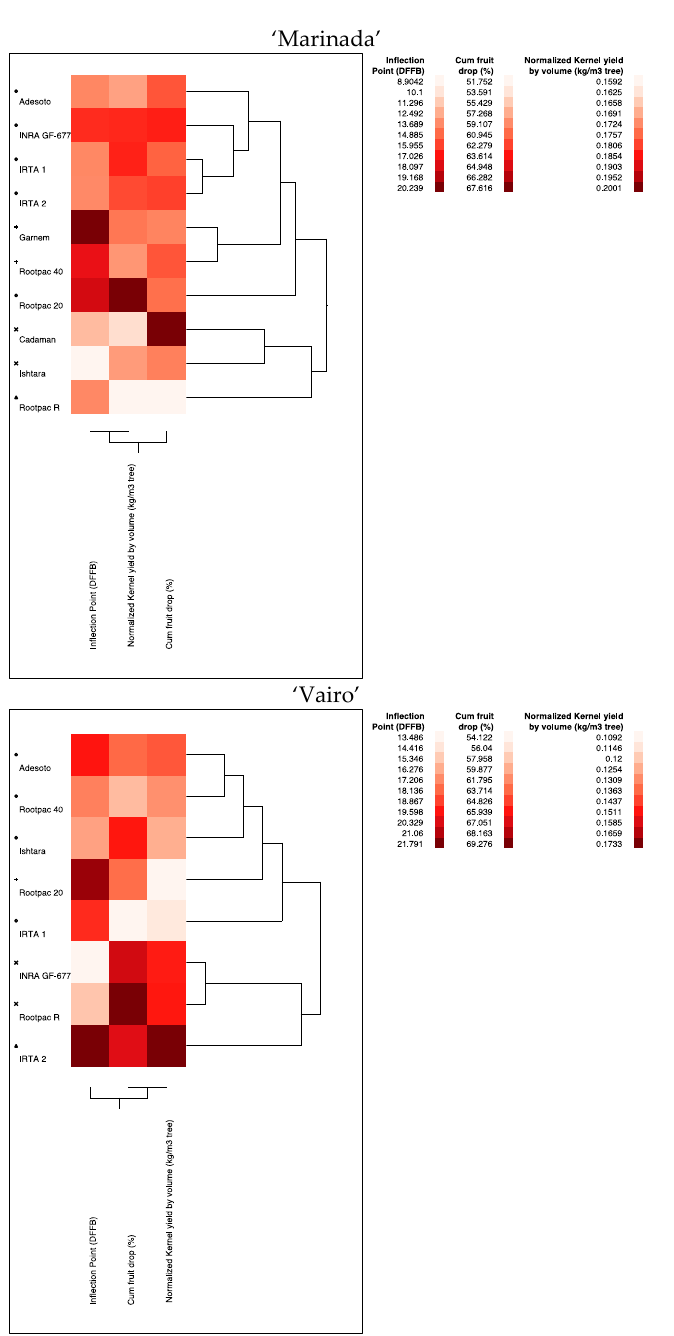
Figure 7. Clustering of ‘Marinada’ and ‘Vairo’ cultivars grafted onto Adesoto, Cadaman ® , Garnem ® , INRA GF-677, IRTA 1, IRTA 2, Ishtara ® , Rootpac ® 20, Rootpac ® 40, and Rootpac ® R rootstocks based on cumulative fruit drop (%), inflection point (days from full bloom that fruit drop began to deac- celerate), and kernel yield (kg/tree) normalized by tree volume (m 3 ) at Les Borges Blanques, Spain (P2). Data were recorded during 2017–2018.